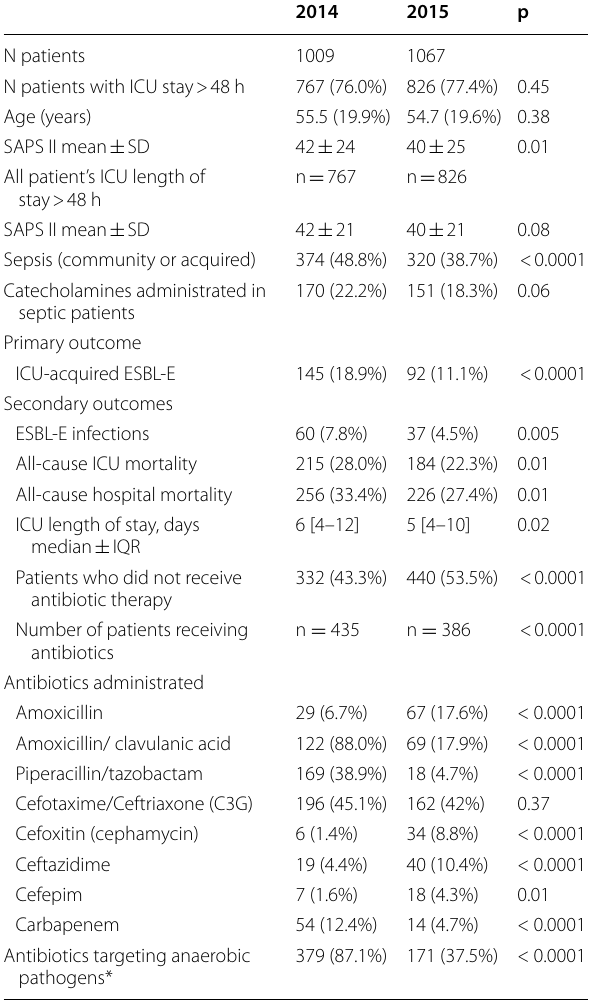
Table 1 Demographic characteristics, outcomes and antibiotics used